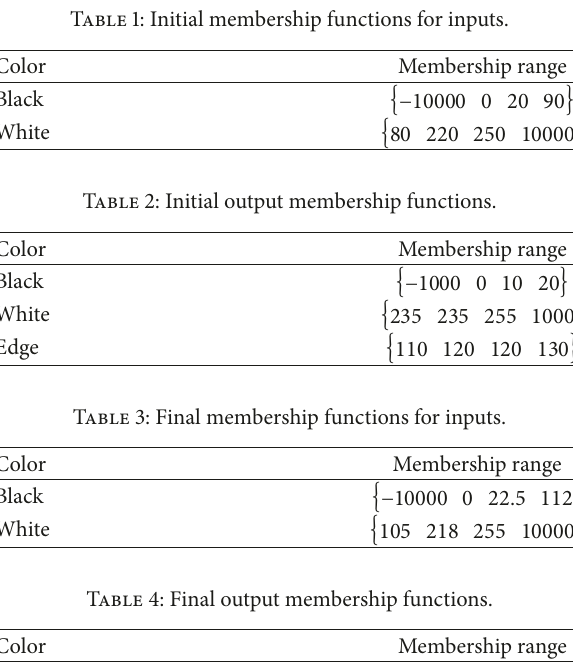
Figure 9: Second tested image.